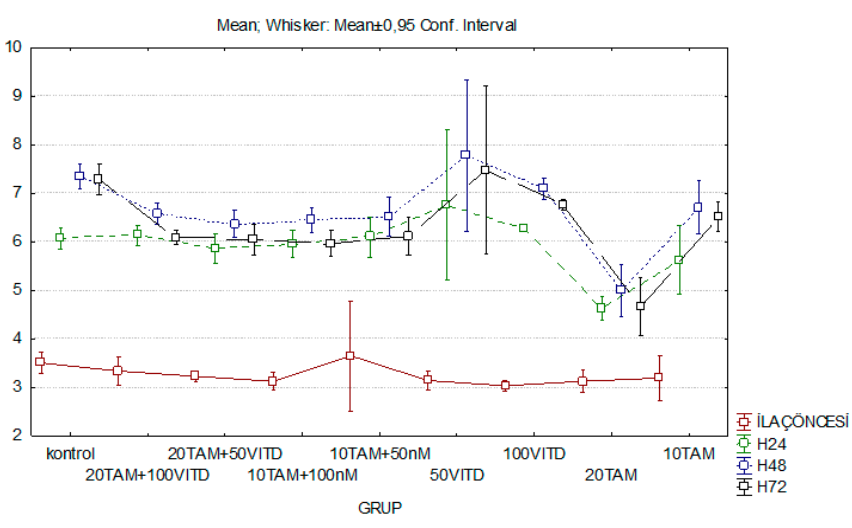
Figure 1. Graph of time-dependent variation of the cell index of Tamoxifen, vitamin D and Tamoxifen + vit D combination at different concentrations between the 24th, 48th and 72th